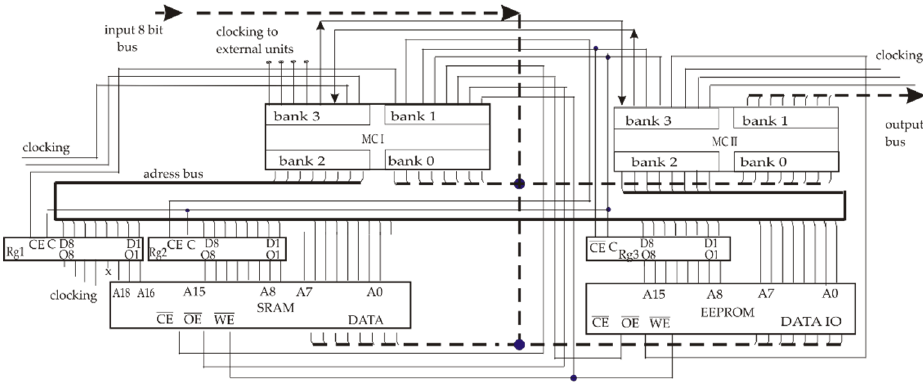
Figure 8. Scheme of the testing circuit board for AGA microassembler software (shortened).